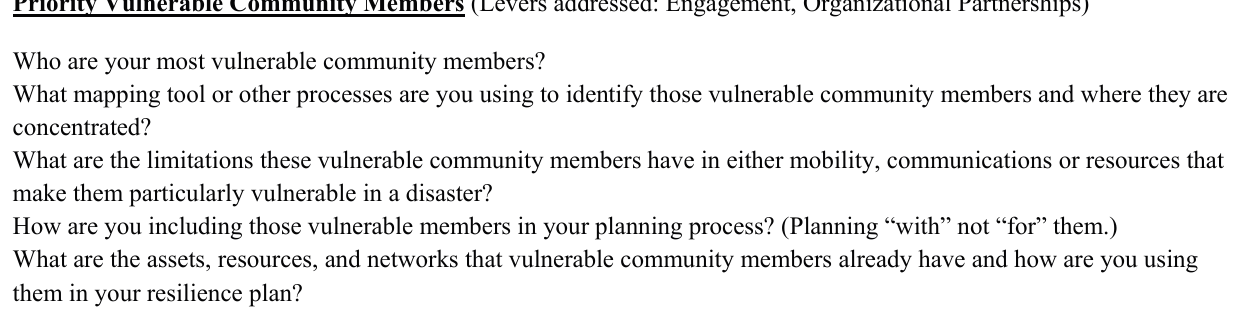
Table 3. Community Resilience